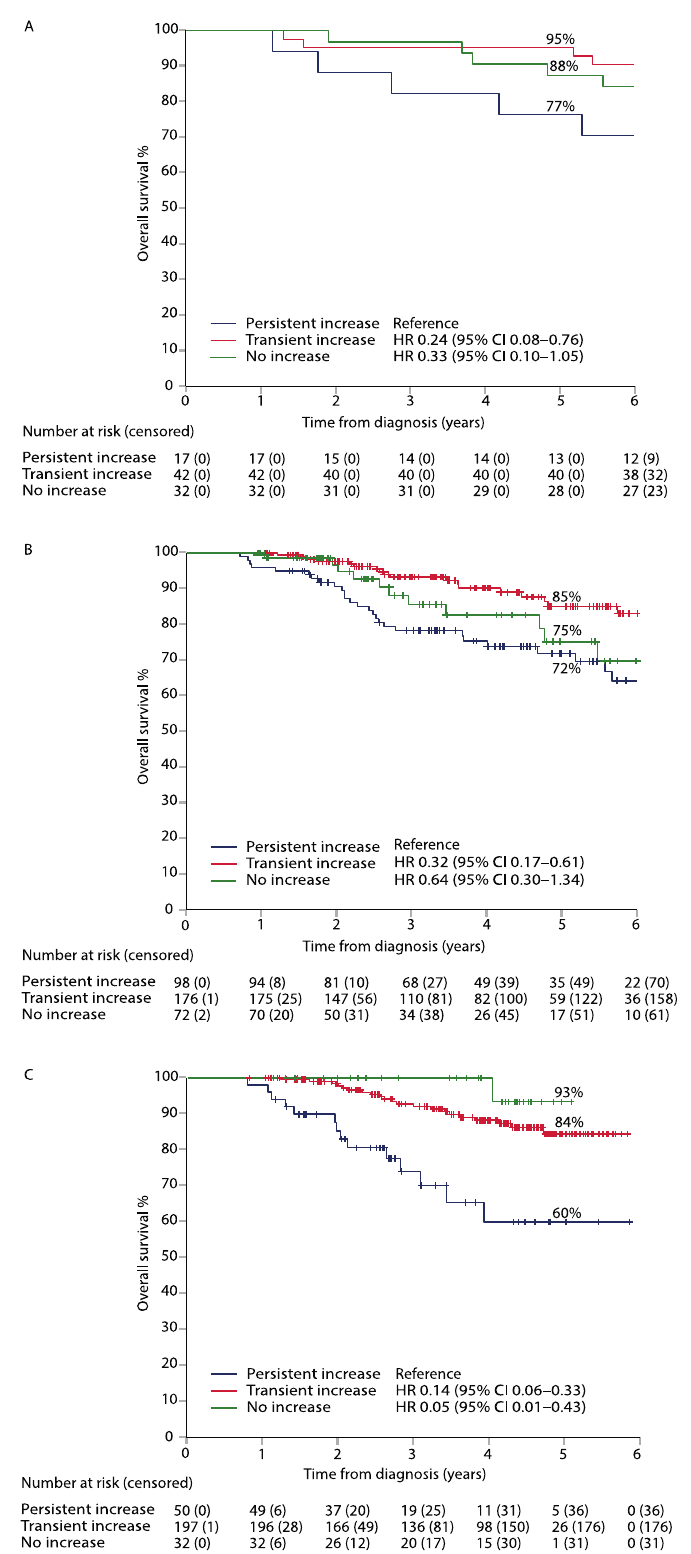
Figure 2. Overall survival (OS) (panel ( A )) in the LIPSYT study, TAUH (panel ( B )), and TUH (panel ( C )) validation data, according to CEA dynamics within reference during adjuvant therapy.